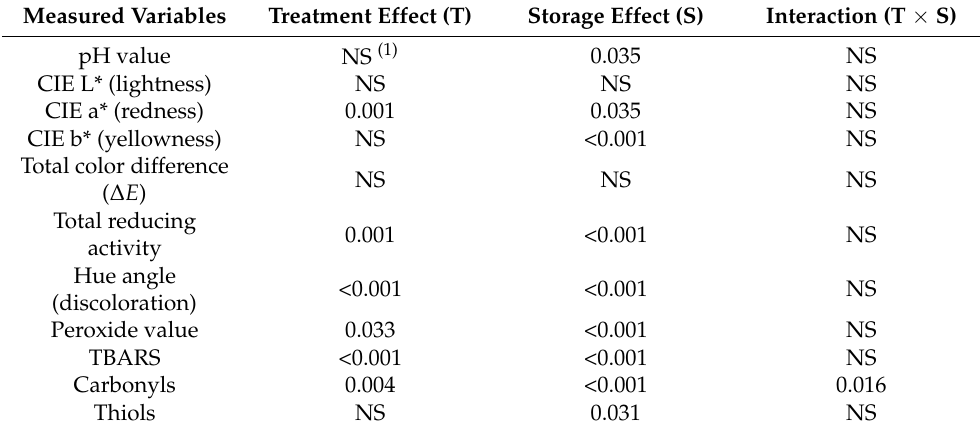
Table 2. The significance of p value from the two-way ANOVA for treatment, storage, and their interaction effects on measured variables.